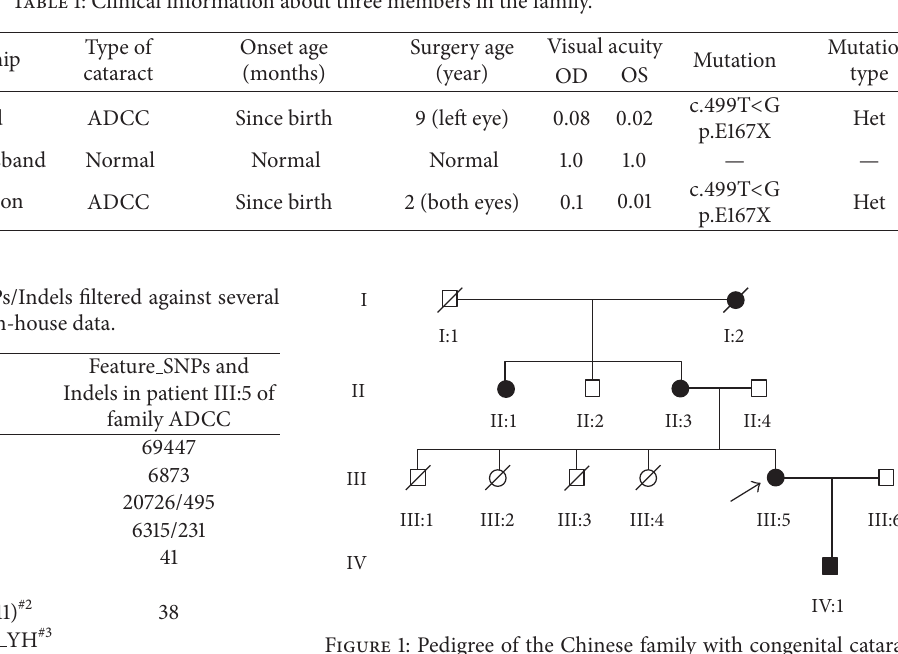
Table 1: Clinical information about three members in the family.